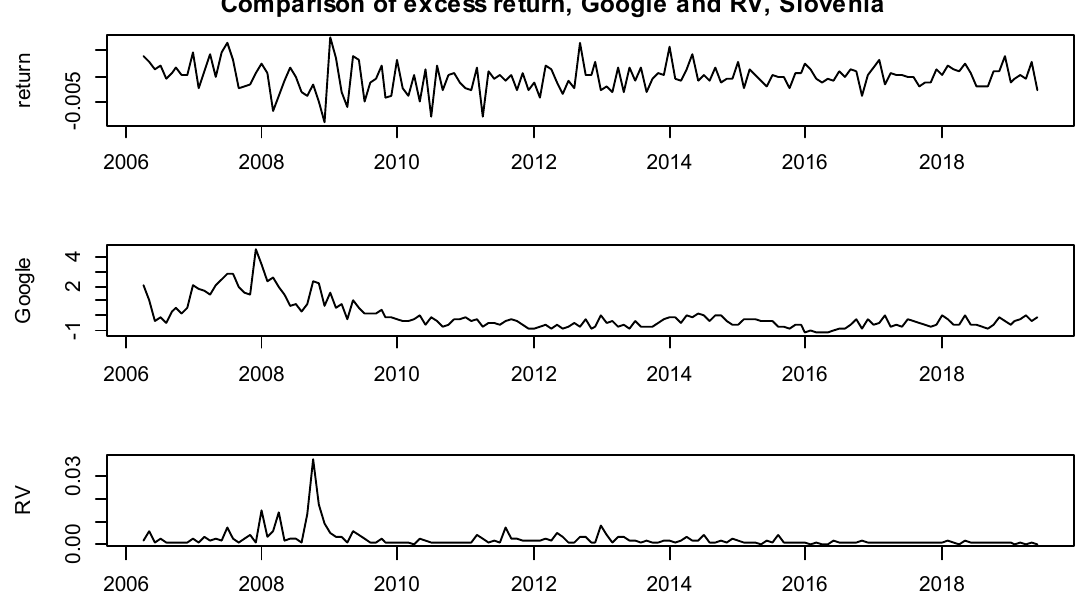
Figure A8. Comparison of monthly series: Excess return, RV and Google search volume, Slovenia.